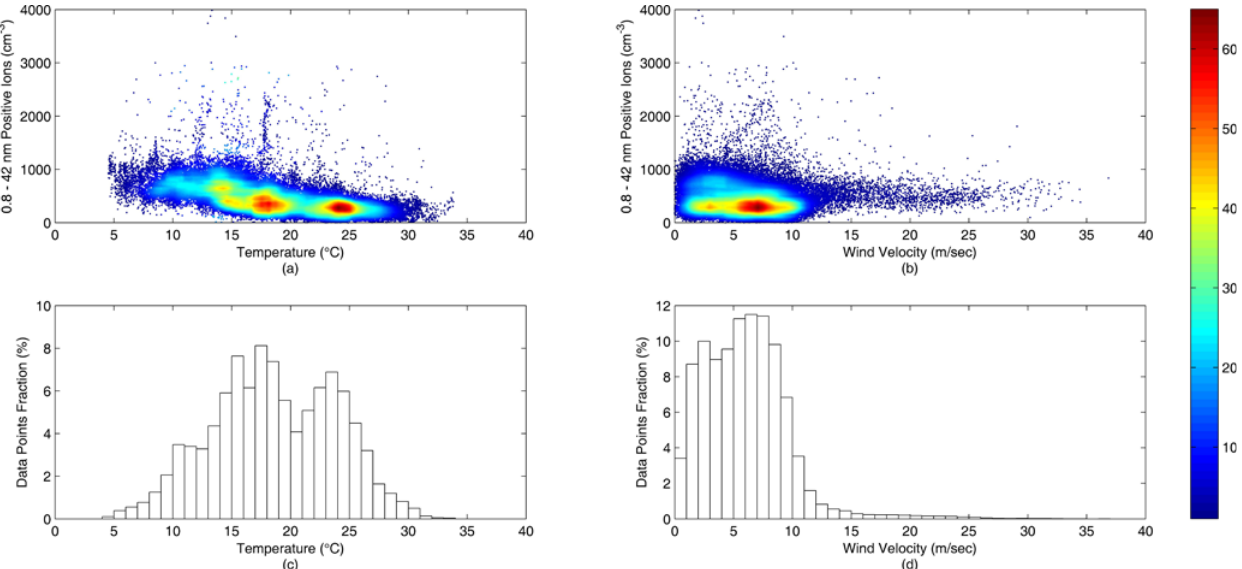
Fig. 3. Variability of positively charged atmospheric ion concentrations in the size range 0.8–42nm depending on temperature and wind velocity (a, b) , and data fraction for positive ions with respect to temperature and wind velocity (c, d)